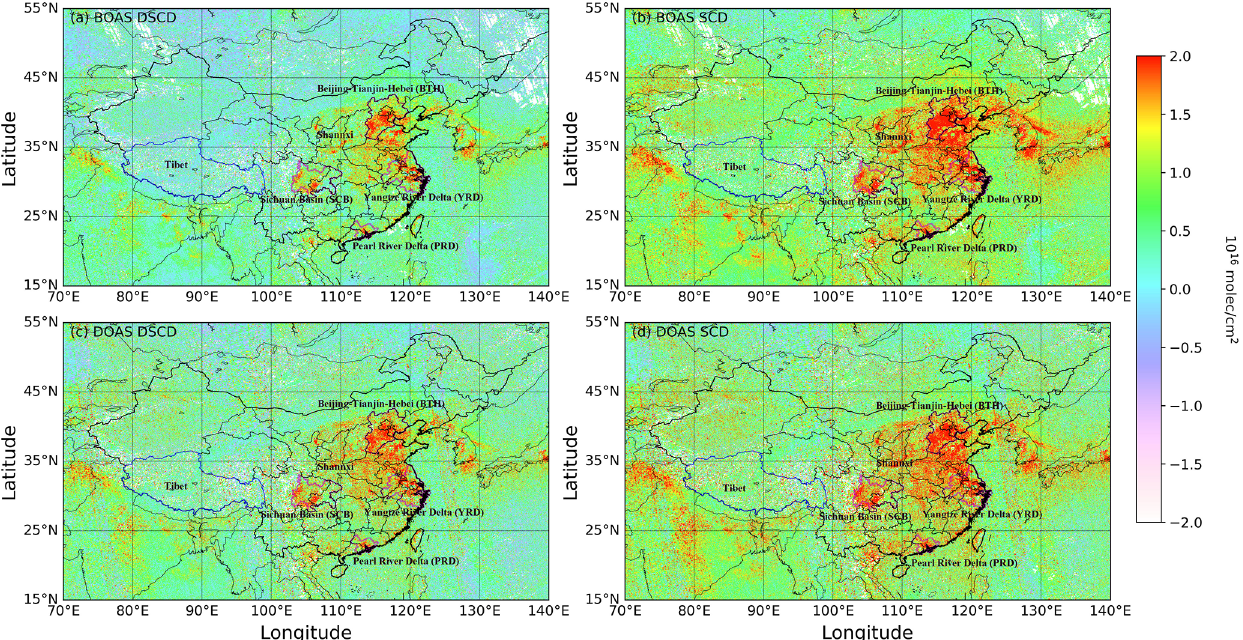
Figure 4. Spatial distributions of BOAS (a) and DOAS (c) HCHO DSCDs and BOAS (b) and DOAS (d) HCHO SCDs on 6 August 2018 over China from orbit 04210 to orbit 04213. The regional boundaries of BTH, YRD, PRD and SCB are delineated by magenta lines.